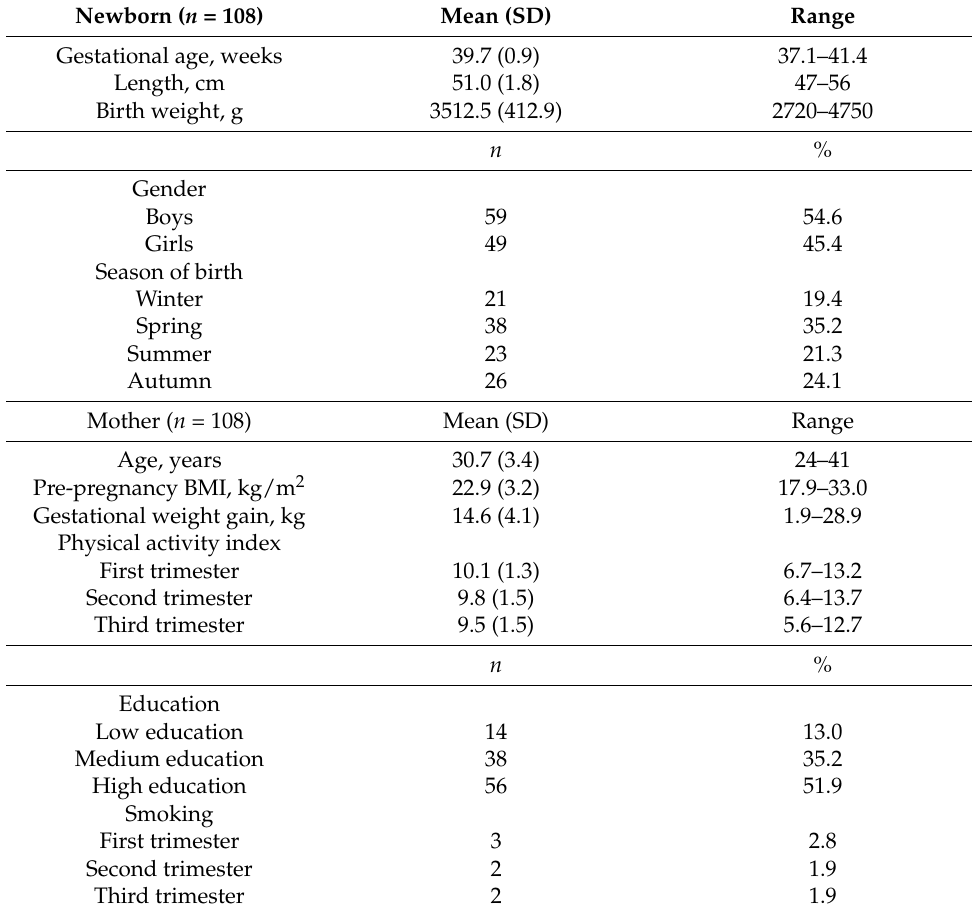
Table 1. Characteristics of the newborns and